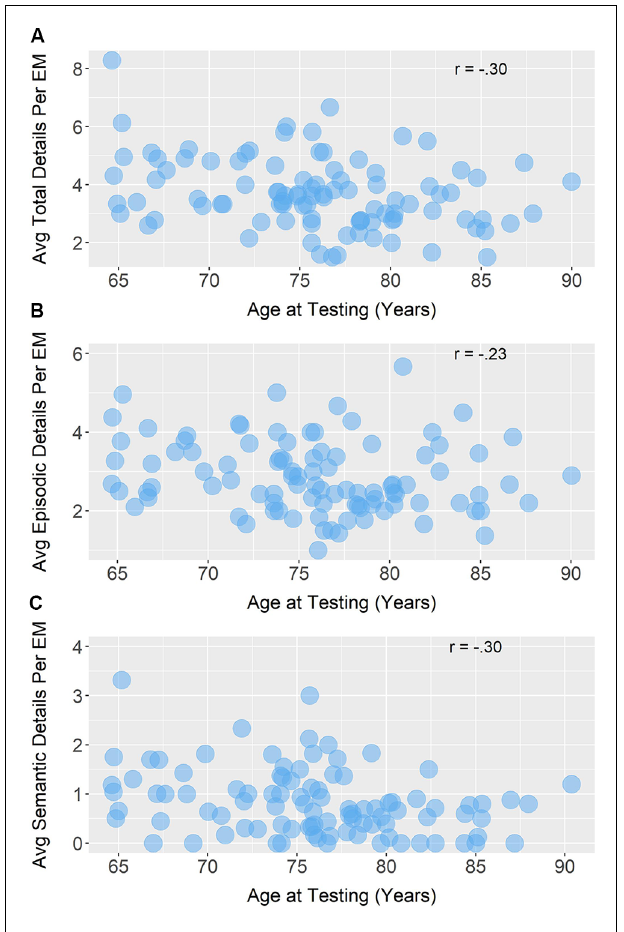
FIGURE 5 | Bivariate Spearman correlations between average (avg) (A) total, (B) episodic, and (C) semantic details produced in sound files containing future episodic thoughts (FET) and